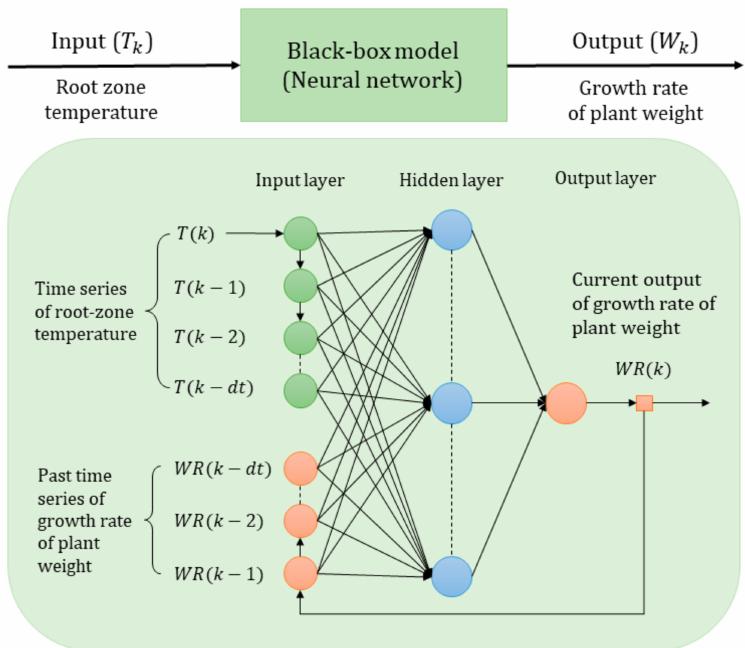
Figure 2. Block diagram of the single input–single output (SISO) system for system identification, and non-linear autoregressive with exogenous input (NARX) network structure with three layers, one input time series of the root zone temperature T ( k ) , one hidden layer (h), one output time series of the growth rate of plant weight WR ( k ) , and a time-delay ( dt ) neural network for identifying a dynamic